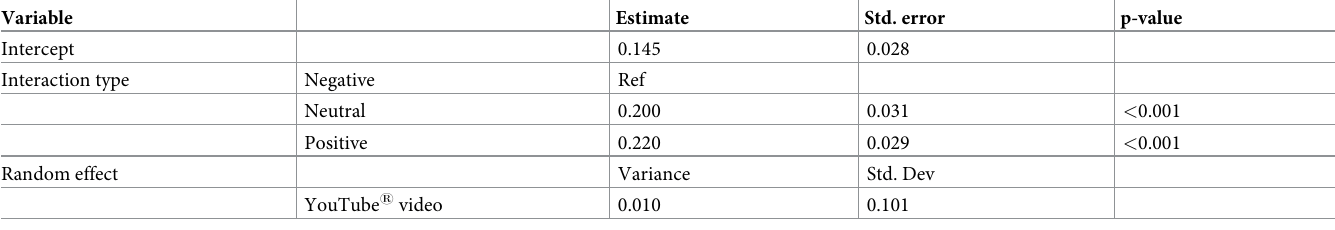
Table 3. Variables associated with emoji sentiment of 346 YouTube 1 videos of exotic cats and primates uploaded between 2006 and 2019.